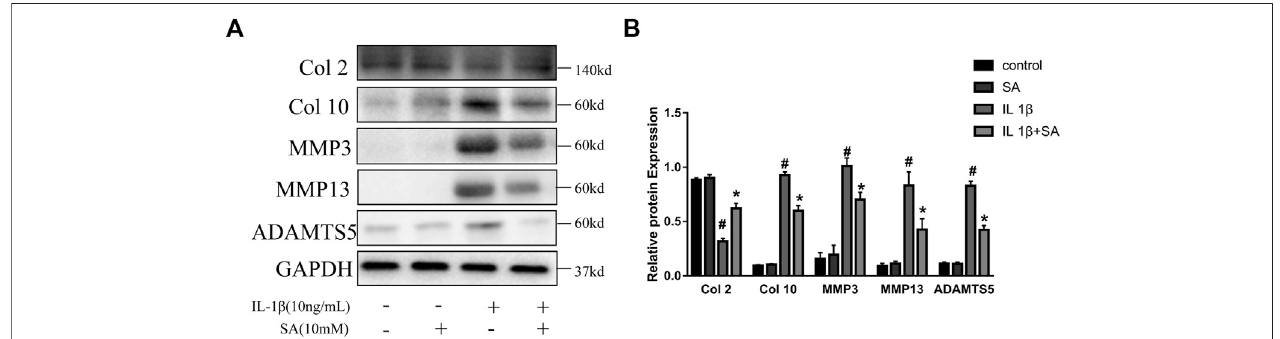
FIGURE 3 | SA attenuates IL-1 β -stimulated anabolic and catabolic dysregulation in SW1353 cells. Representative western blots and quanti fi cation data showing theCol2,Col10,MMP3,MMP13,andADAMTS5expressionincellstreatedasdescribedabove.Thedataareshownasthemean ± SD( n (cid:2) 3). # p < 0.05vs.thecontrol group; * p < 0.05 vs. the IL-1 β